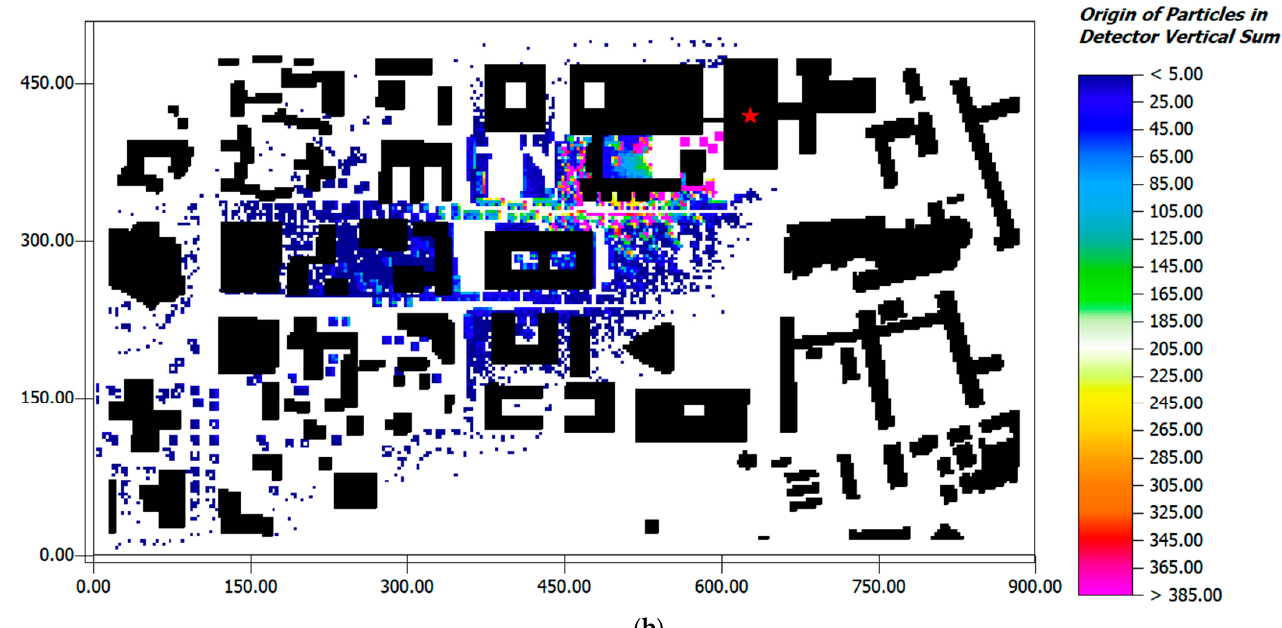
Figure 10. Three-dimensional ( a ) and two-dimensional ( b ) visualization of origin of particles in the complex model area. The red star in ( b ) represents the detector location.